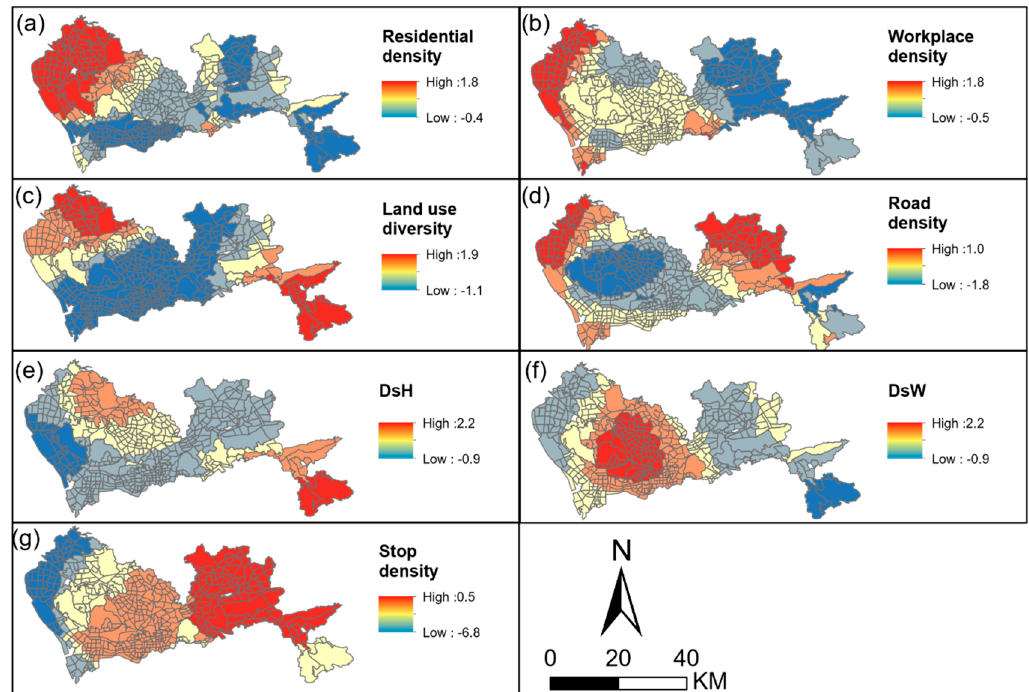
Figure 8. Local coefficients for taxi ECI. ( a ) Residential density; ( b ) workplace density; ( c ) land use diversity; ( d ) road density; ( e ) distance between the nearest transit stop and home (DsH); ( f ) distance between the nearest transit stop and work (DsW); ( g ) stop density.